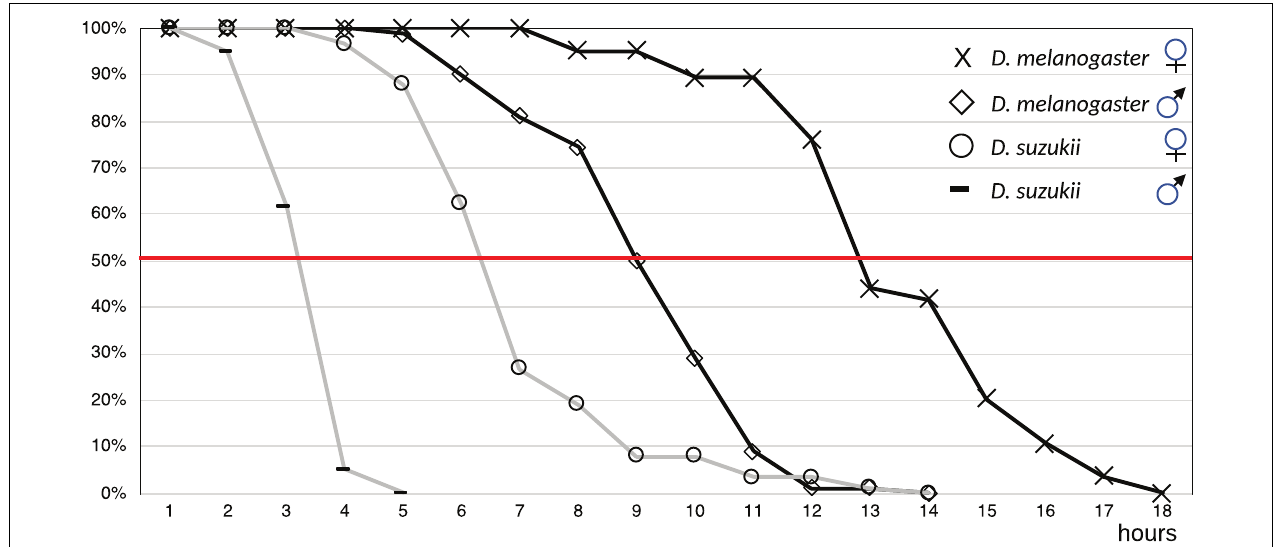
FIGURE 1 | D. suzukii and D. melanogaster flies were incubated at low air humidity ( < 10%). Survival of flies was recorded until all flies had died. Females and males were tested separately as it is known that females are generally more robust than males. The TL50 values are 3–4 h for D. suzukii males, 6–7 h for D. suzukii females, 9–10 h for D. melanogaster males, and 13–14 h for D. melanogaster females. Following a log-rank test, the p -values for the differences between males and between females of both species were calculated; they are < 0.0001 for both comparisons.